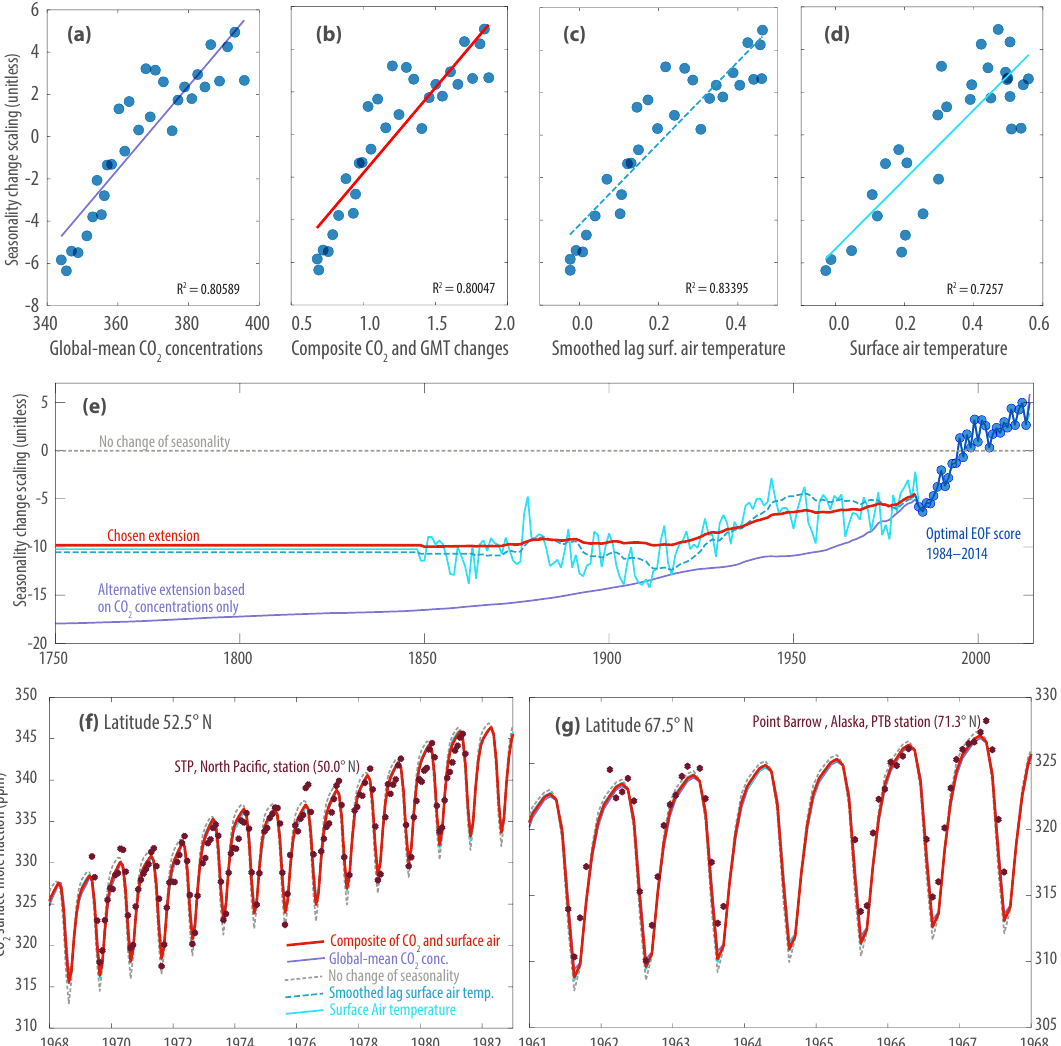
Figure 5. Comparison of various scaling options for the change of seasonality of CO 2 concentrations over time. The first EOF of the residual fields of observations minus the mean 1984–2014 CO 2 seasonality (Fig. 9a.2) is scaled with an EOF score. Before 1984, this EOF score is regressed against a composite of global-mean CO 2 concentrations and global-mean surface air temperatures (see text and panel b ). Alternative regressors include global-mean CO 2 concentrations (a) , lagged averages of monthly global-mean surface air temperatures (c) and raw global-mean annual average surface air temperatures (HadCRUT4v) (Morice et al., 2012) (d) . The regressed EOF score back in time is shown in (e) . A comparison to the first CO 2 measurements of higher northern latitudes at so-called Station P (STP) and Point Barrow in Alaska (PTB), where the seasonality change is most pronounced, is provided in (f) and (g) , respectively (see text for